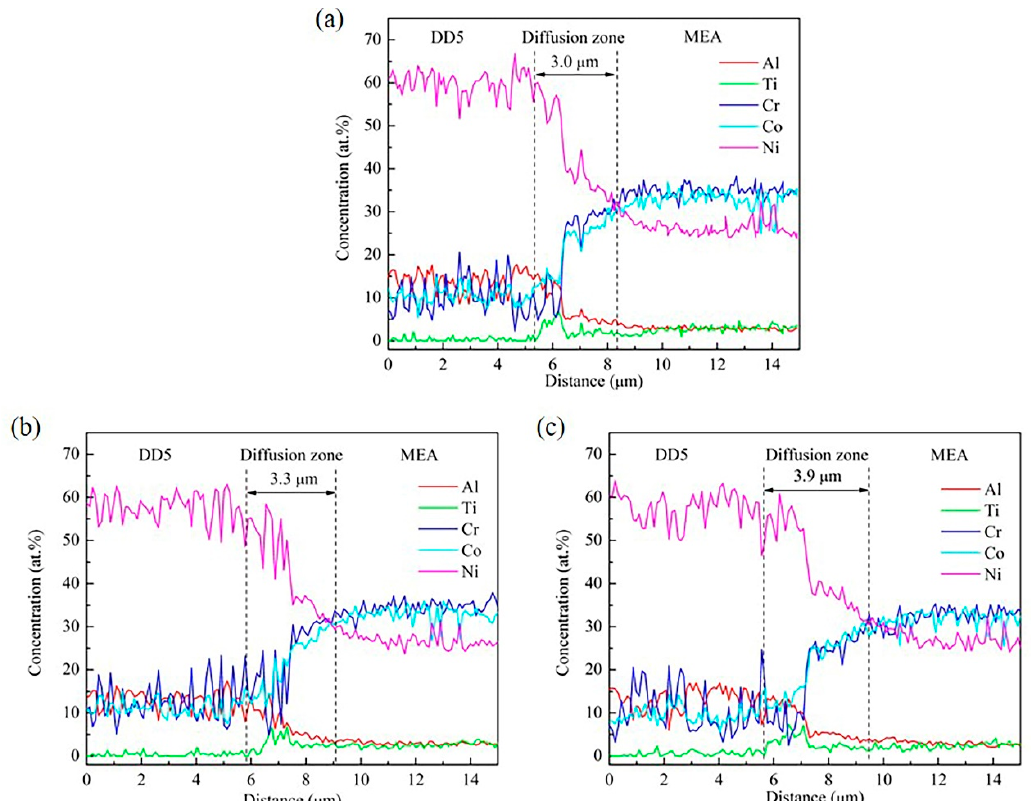
Figure 6. Distribution of chemical composition across the MEA/DD5 interface in the joints diffusion-bonded at different temperatures: ( a ) 1020 °C, ( b ) 1050 °C, and ( c ) 1080 °C. Table 2. Grain size of the (CoCrNi) 94 Al 3 Ti 3 MEA in different states ( μ m).